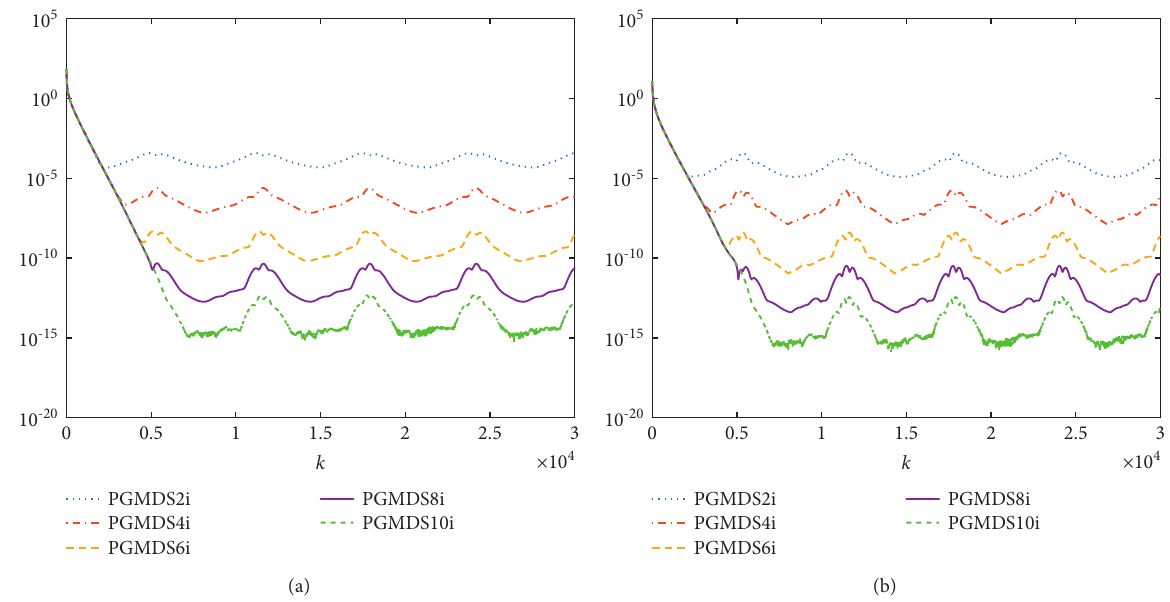
Figure 9: Residual error trajectories synthesized by five PGMDS algorithms for example 2 (with ϵ � 0 . 001 s and c � 5 . 0). (a) Trajectories of ‖ X A − I ‖ . (b) Trajectories of ‖ X k + k + 1 k + 1 F